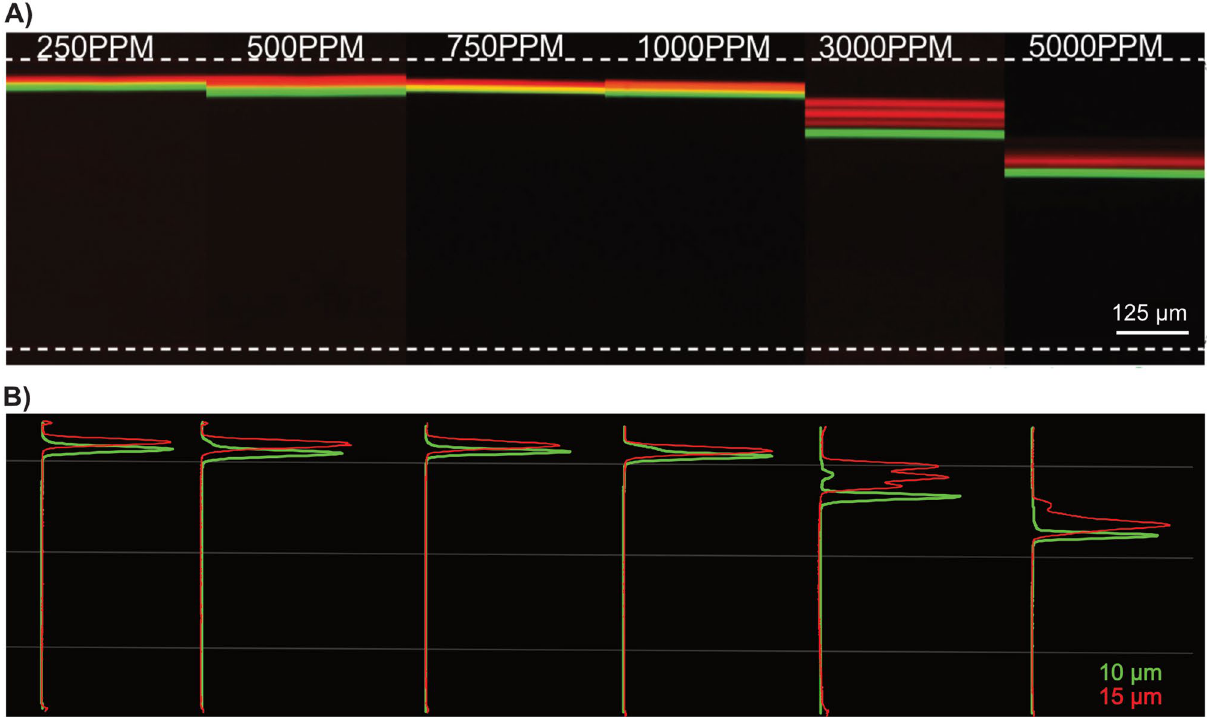
Figure 4. Particle equilibrium focusing position at different PEO concentrations. ( A ) Fluorescence image of 10 (green) and 15 µm (red) particles at the 10th turn for different PEO concentrations. The particle focusing position is pushed away from the outer wall, especially for 3000 PPM and 5000 PPM. Scale bar: 125 µm. ( B ) Corresponding overlapped cross-sectional intensity of the 10 and 15 µm